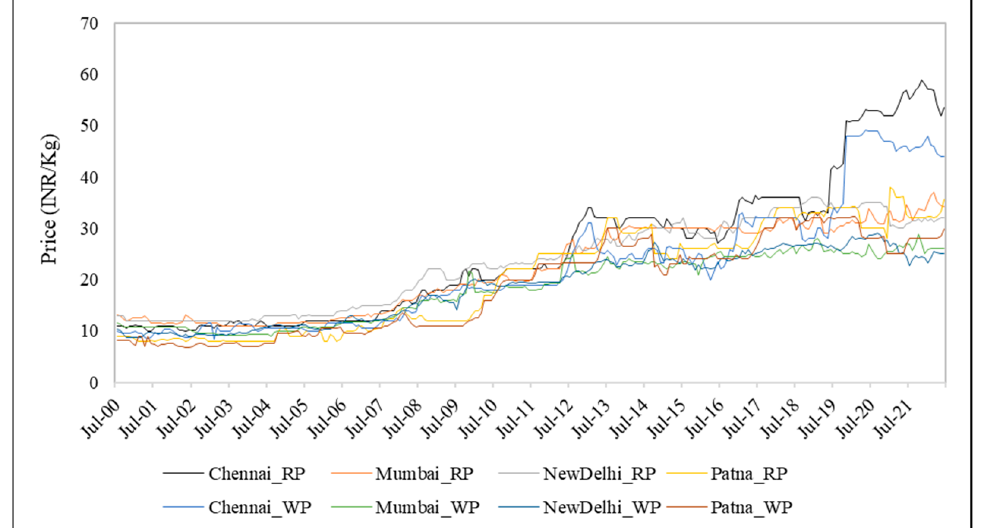
Figure 1. Price trends in selected rice markets of India.